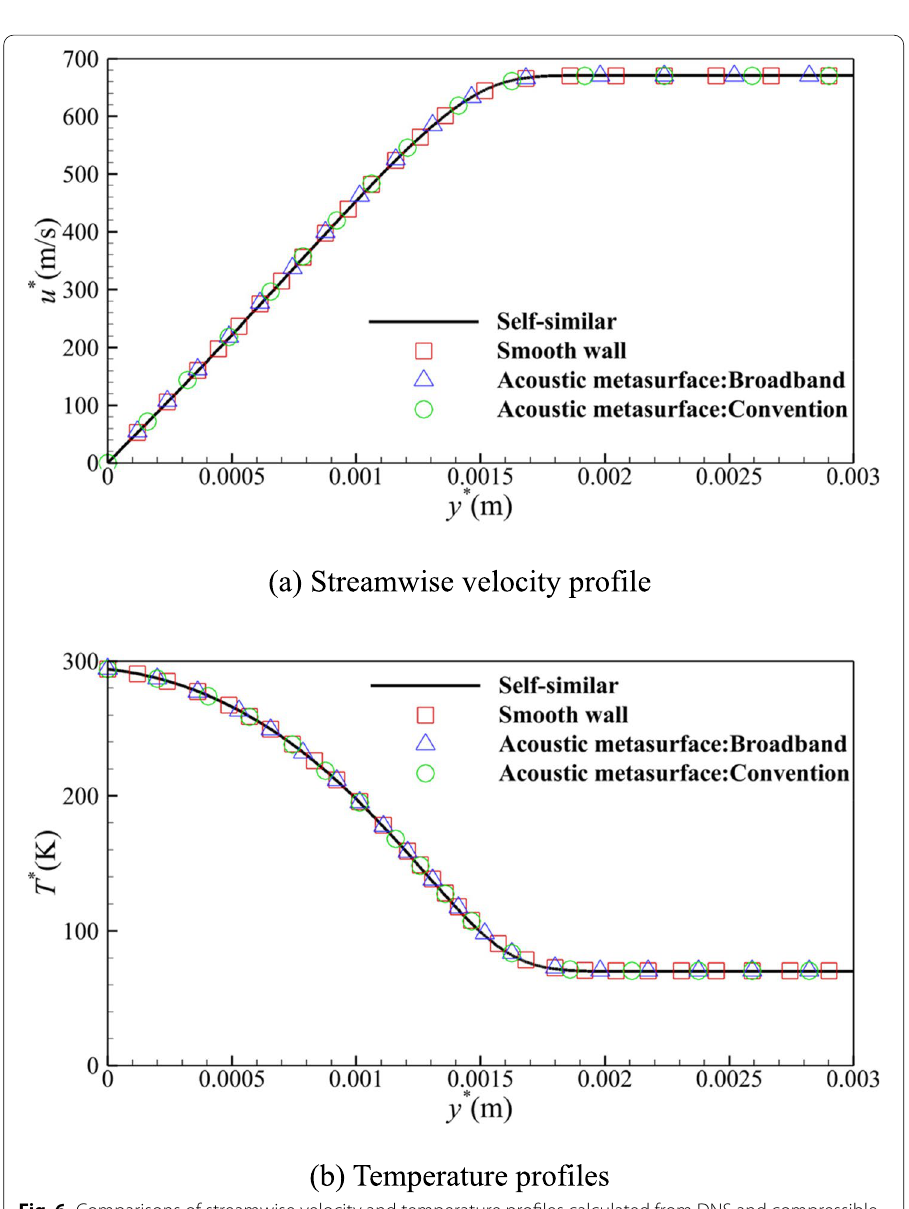
Fig. 6 Comparisons of streamwise velocity and temperature profiles calculated from DNS and compressible Blasius solution at x * 0.24 m above different surfaces. ( a ) Streamwise velocity profile. ( b ) Temperature =